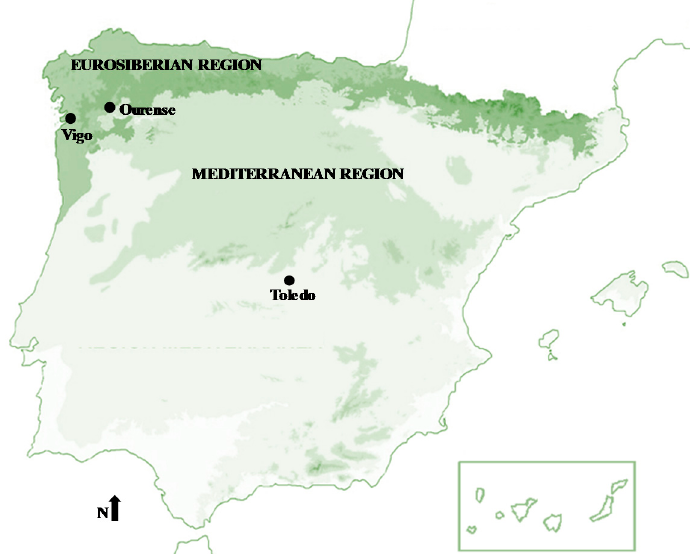
Figure 1. Location of the areas studied.